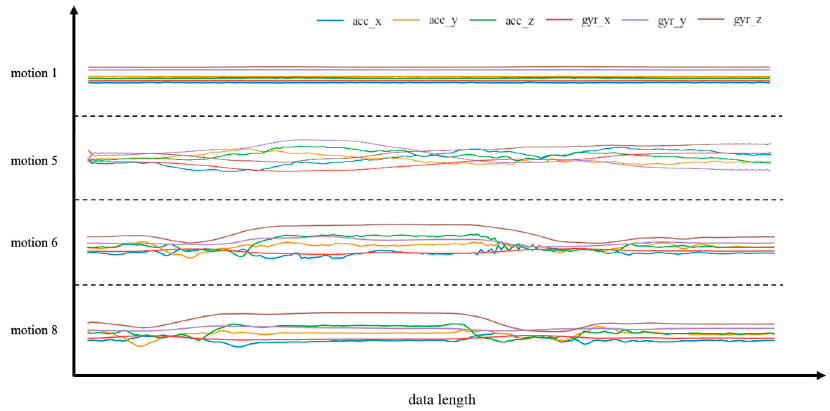
Figure 3. The randomly-selected four different actions of one of the participants and the data of the accelerometer and gyroscope data of the back sensor. The selected actions are as follows: motion 1 (sitting still), motion 5 (turning around and looking around), motion 6 (raising hand while standing up) and motion 8 (standing up and sitting down). We uniformly downsampled the data length to 200 for display clarity. Through motion sensors, we can continuously collect data about different motions, and each motion has a unique motion pattern. The relative intensity of each action is reflected in the ordinate after normalization.